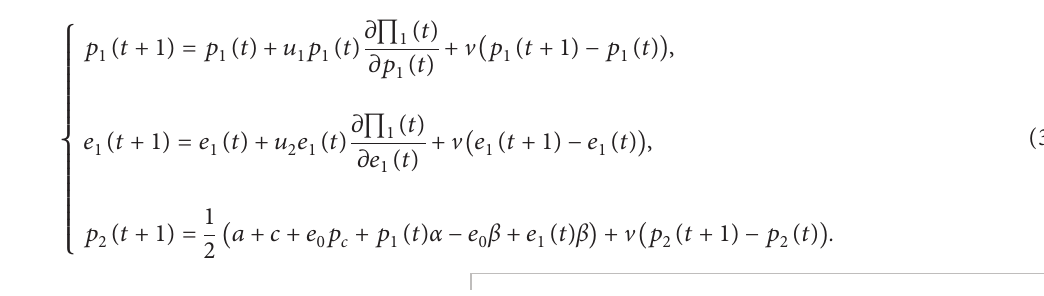
� 0 . 09 and u � 0 . 02: (a) u � 0 . 2 and (b) u � 0 . 1 2